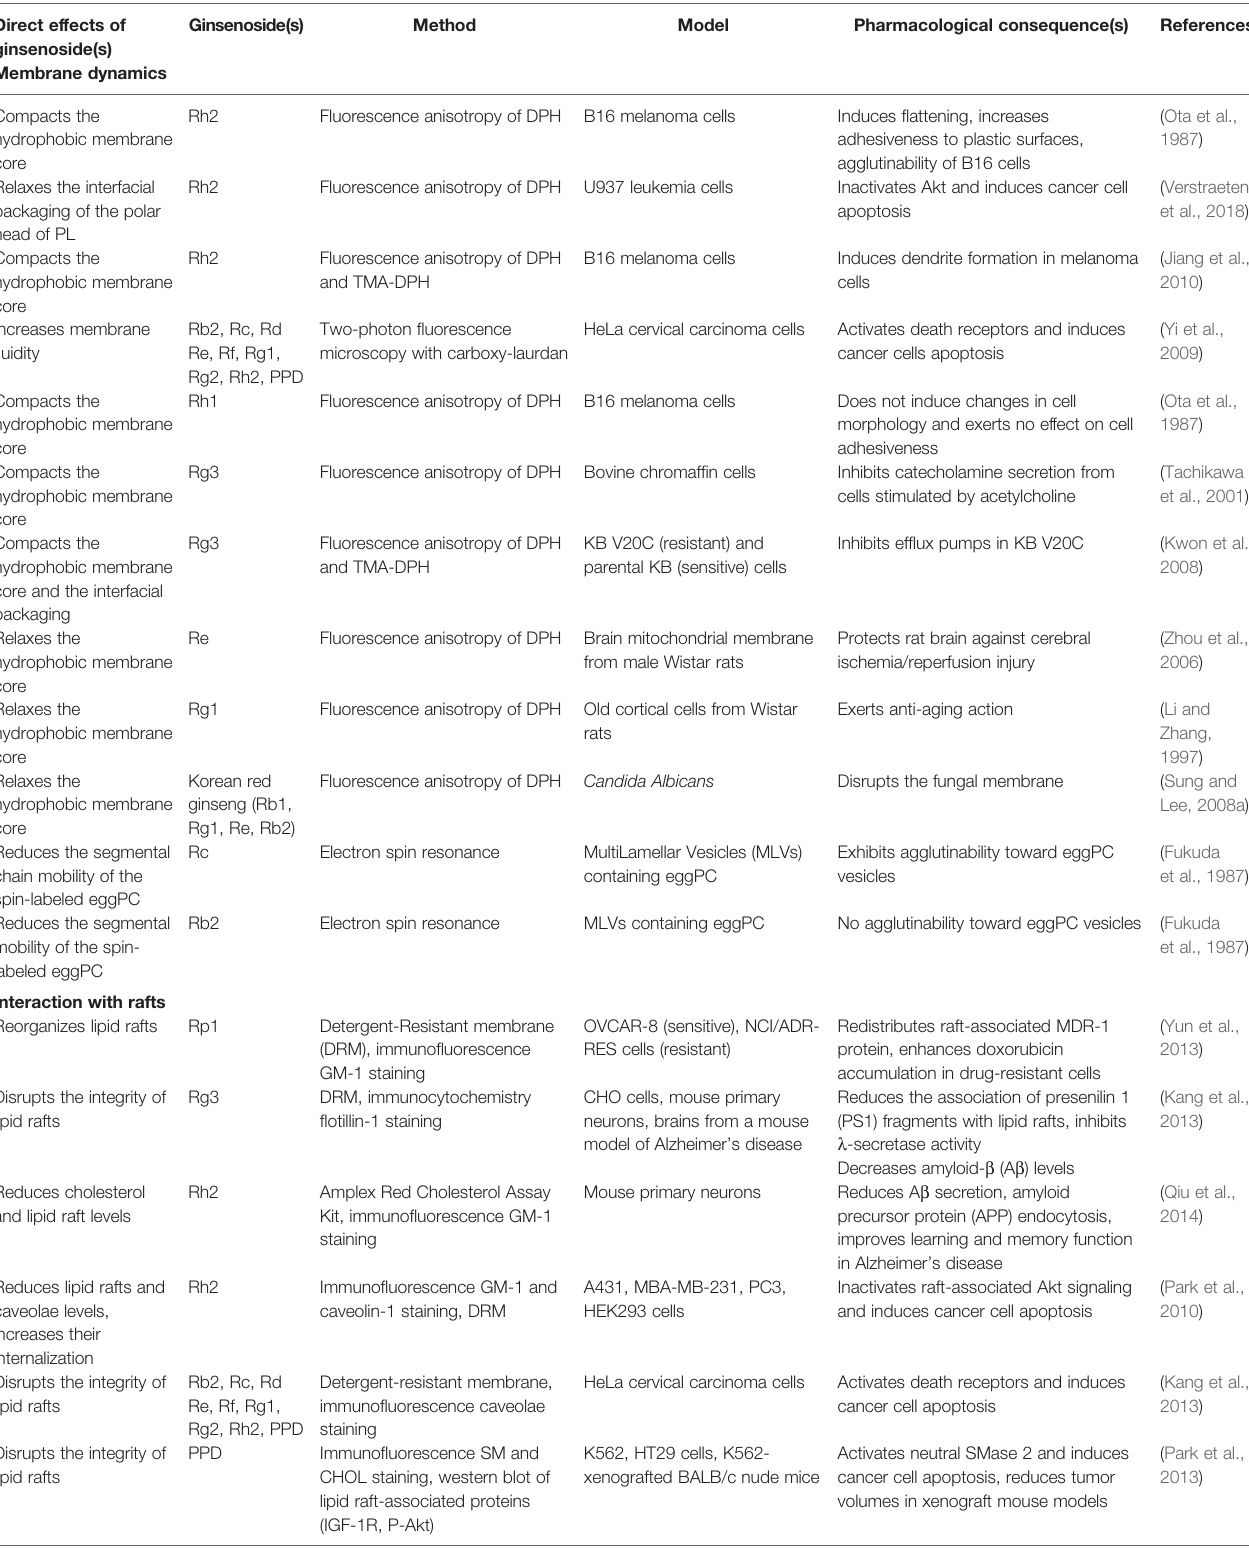
TABLE 1 | Interaction of ginsenosides with membranes and pharmacological